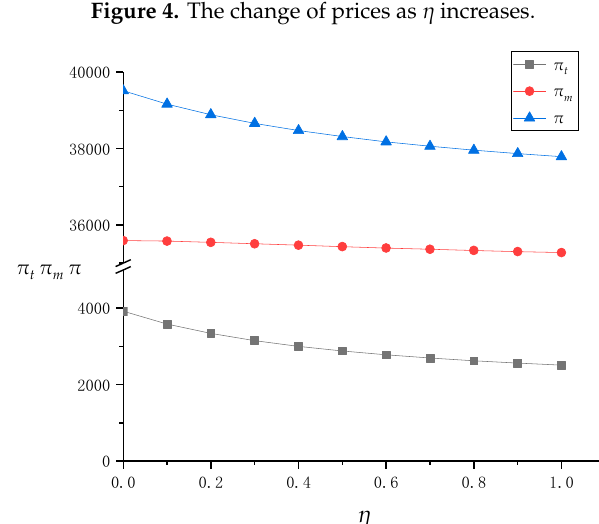
Figure 5. The change of profits as η increases.